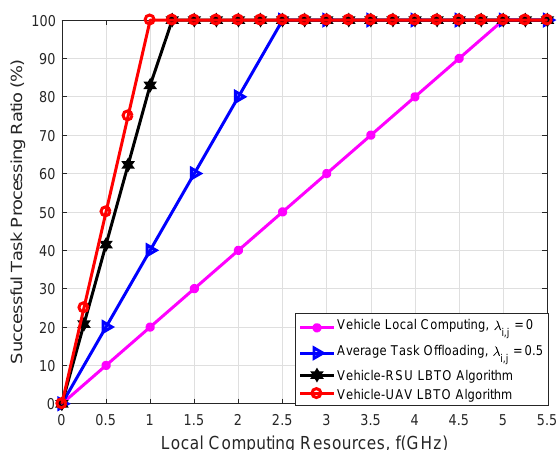
Figure 6. Comparison of the successful task processing ratio with respect to the local computation resources under different